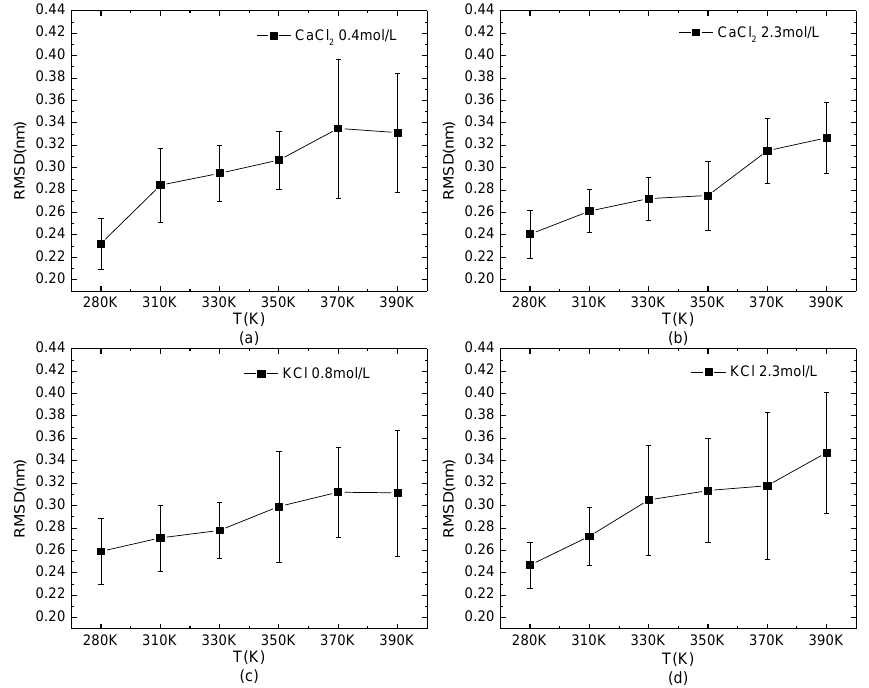
Figure 5. The root mean square deviation of the protein system versus the temperature. The